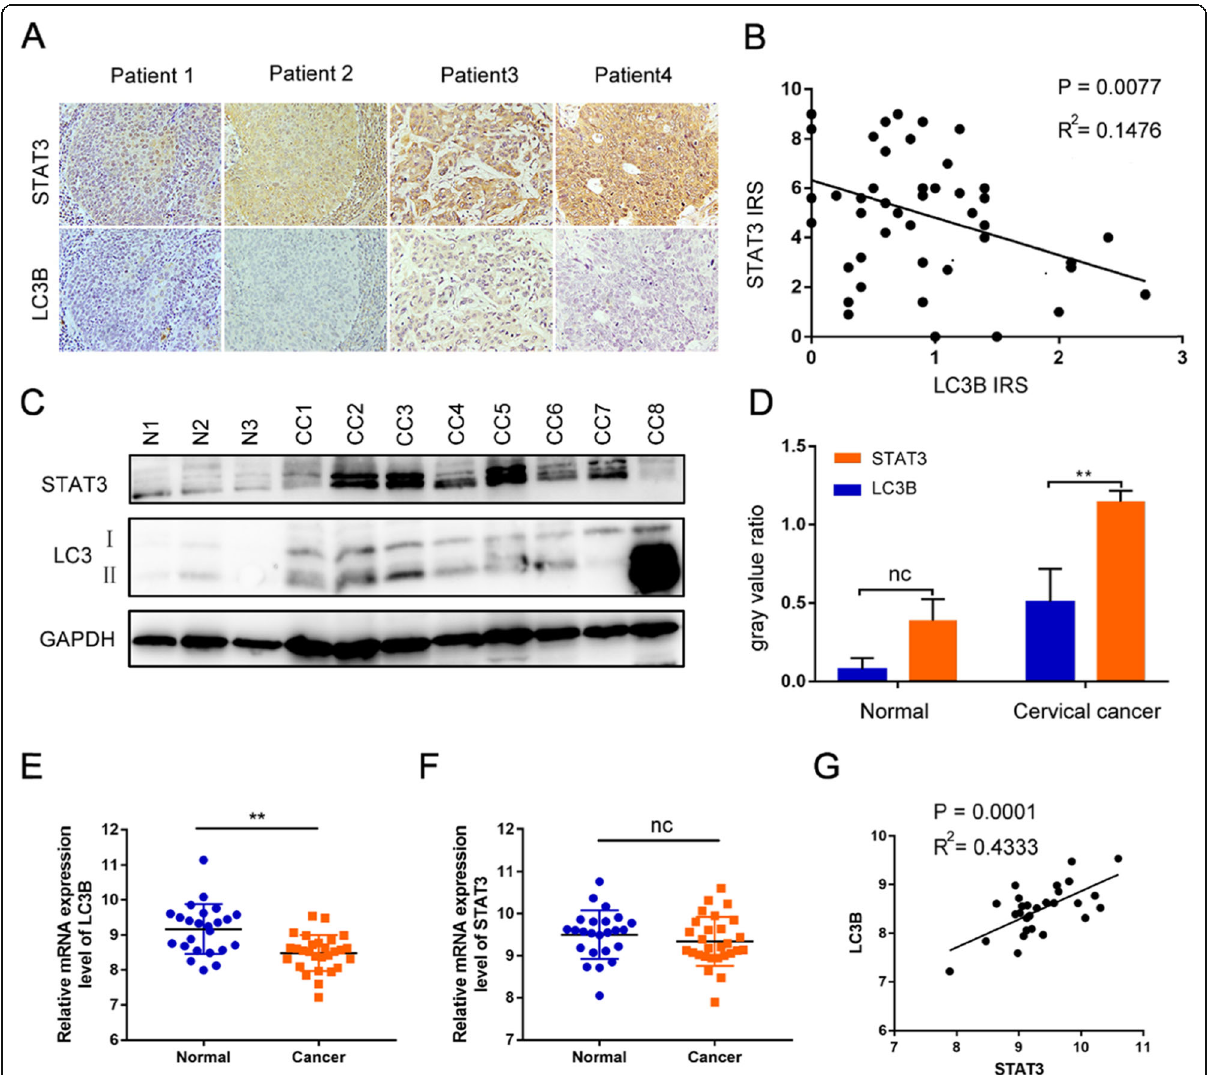
Fig. 1 STAT3 is highly expressed in cervical cancer patients and is negatively correlated with LC3B. A . the expressions of STAT3 and LC3B in cervical cancer patients; B . The STAT3 immunoreactive score (IRS) is negatively related to LC3B IRS; C and D . P-STAT3 and LC3B were detected by western blotting, then analyzed by Image J; E . The mRNA expression of LC3B in normal cervical tissue was significantly higher than that in cervical cancer by GDS3233. F . The mRNA expression of STAT3 in normal cervical tissue was no different with that in cervical cancer. G . STAT3 correlates positively with LC3B at the mRNA level. ( “ ns ” no significance, “ * ” p <0.05, “ ** ” p